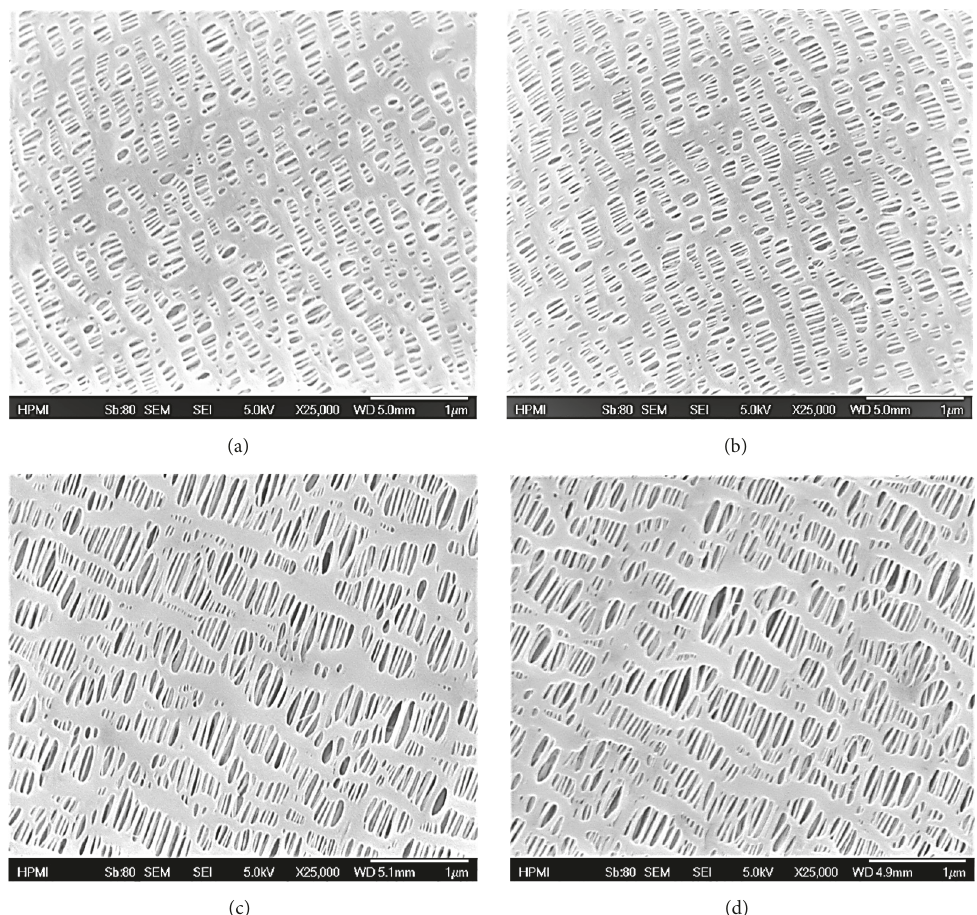
Figure 1: SEM images of the Celgard commercial separators trilayers (a) H2013 (porosity 45%) and (b) H2512 (porosity 50%); monolayers